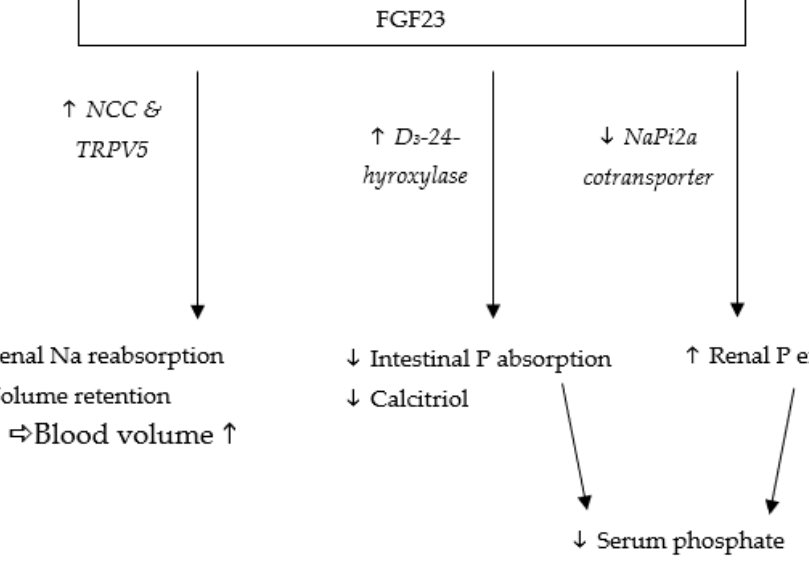
Figure 1. Selected physiological effects of FGF23 on sodium and phosphate metabolism, as established in humans and rodents.